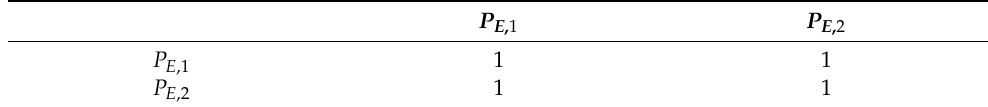
Table 11. Judgment matrix in the indicator layer ( P E ,1 – P E ,2 ). P E , 1 P E , 2 P E ,1 1 1 P E ,2 1 1